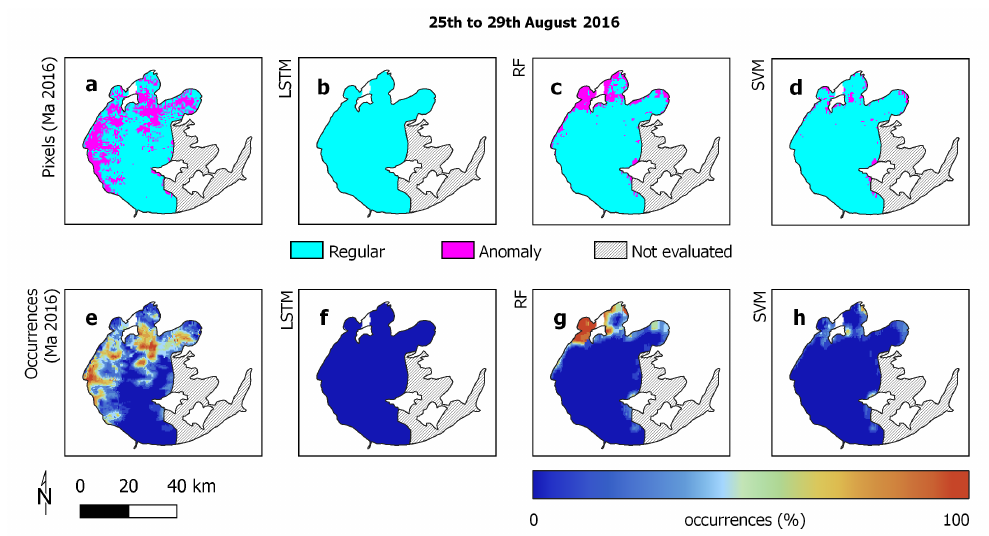
Figure 15. Period trend forecasting based on pixels ( a – d ) and occurrences ( e – h ) from 25–29 August 2016, related to Lake Taihu. Plots ( a , b ) represent the mapping of the reference data.